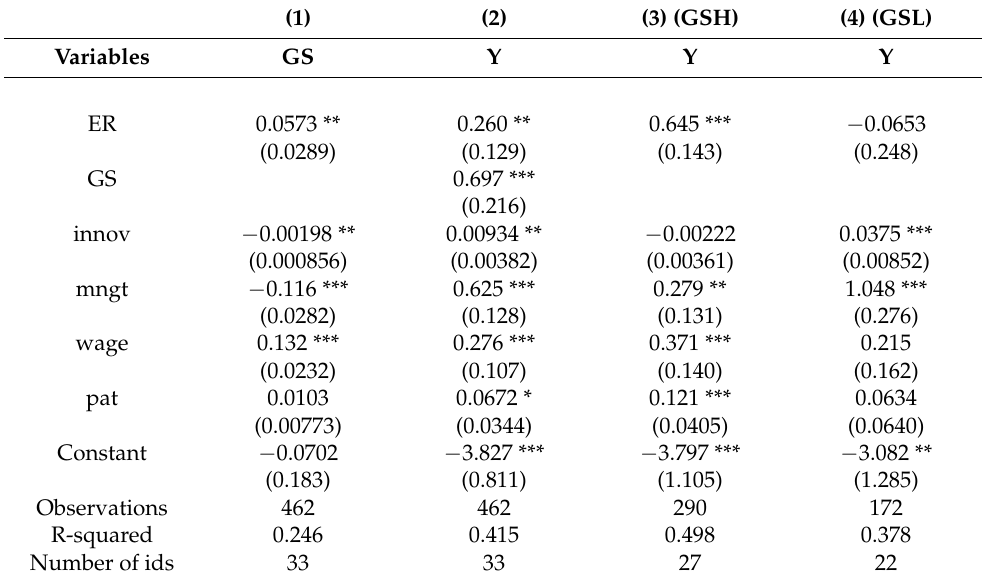
Table 4. Robustness